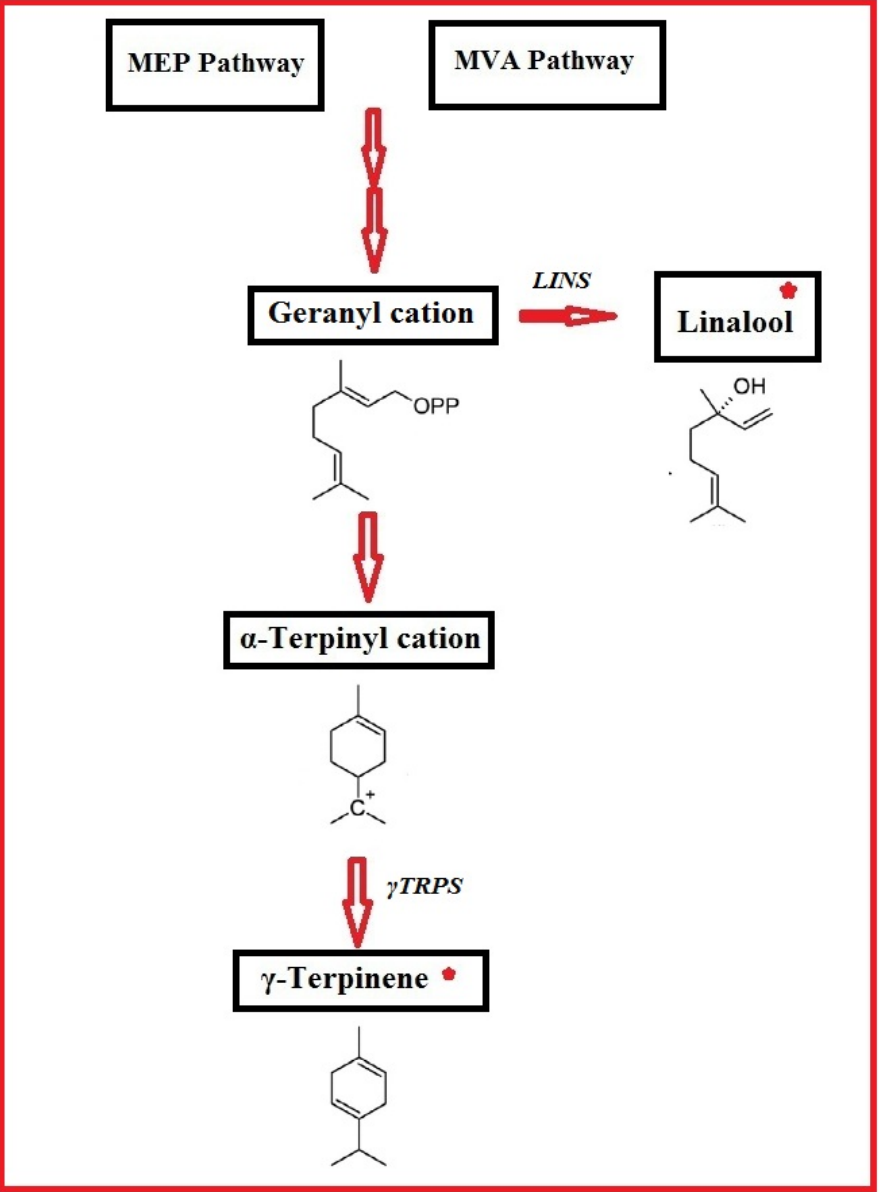
Figure 1. Conversion of geranyl diphosphate to (S)-linalool by LINS , and to other monoterpene products by TRPS .